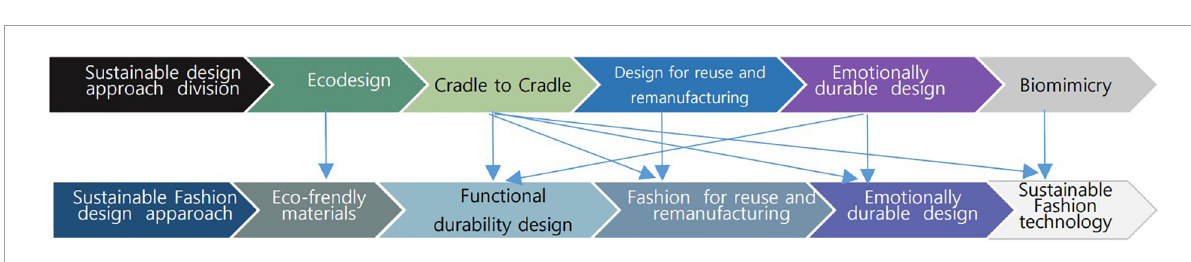
FIGURE4 Design approach classification process of sustainable fashion brand